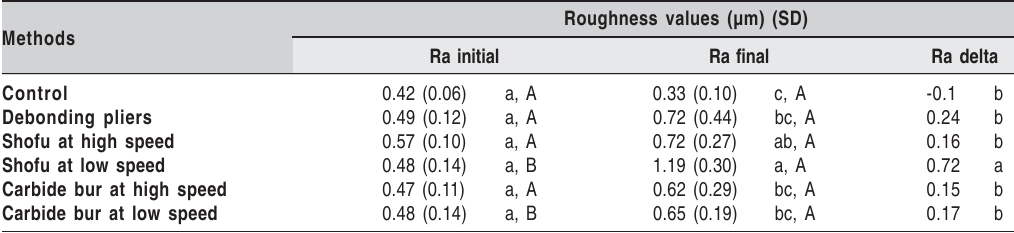
Table 1. Surface roughness (Ra) (standard deviation) of enamel before bracket bonding and after removal the residual adhesive using different